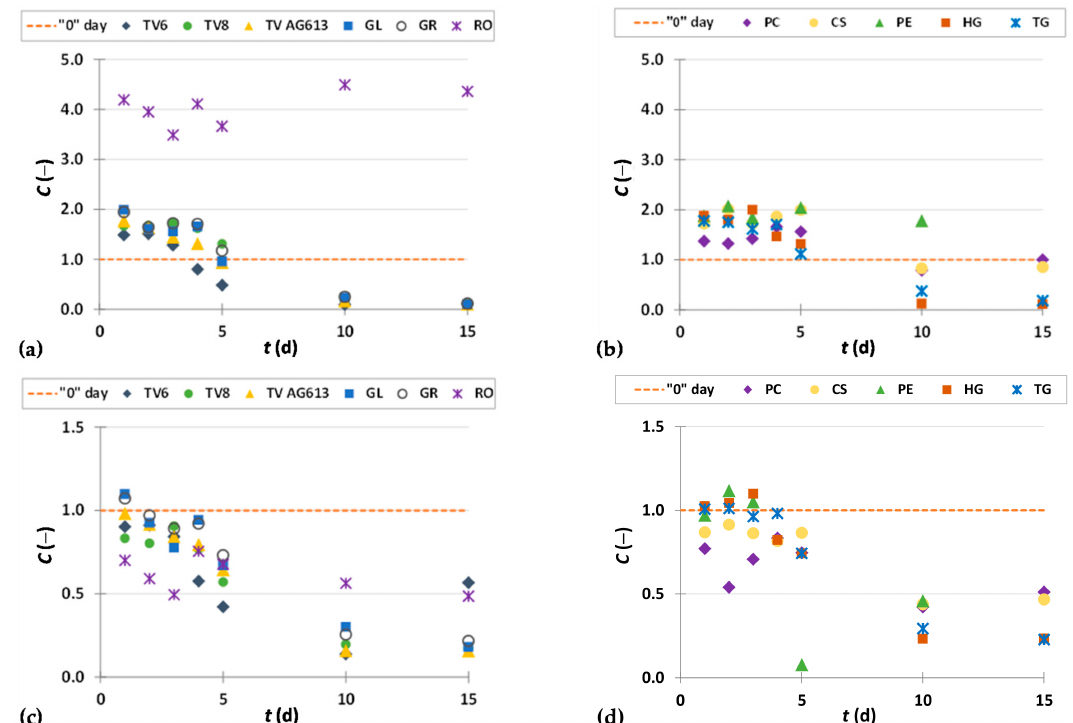
Figure 9. Dimensionless content ( C = C i / C o ) of procyanidin B1 ( a , b ) and procyanidin B2 ( c , d ) in GP extracts before biological treatment (‘0’ day) and after 1–15 days of biological treatment with TV6, TV8, TV AG613, GL, GR, RO ( a , c ), and PC, CS, PE, HG, TG ( b , d